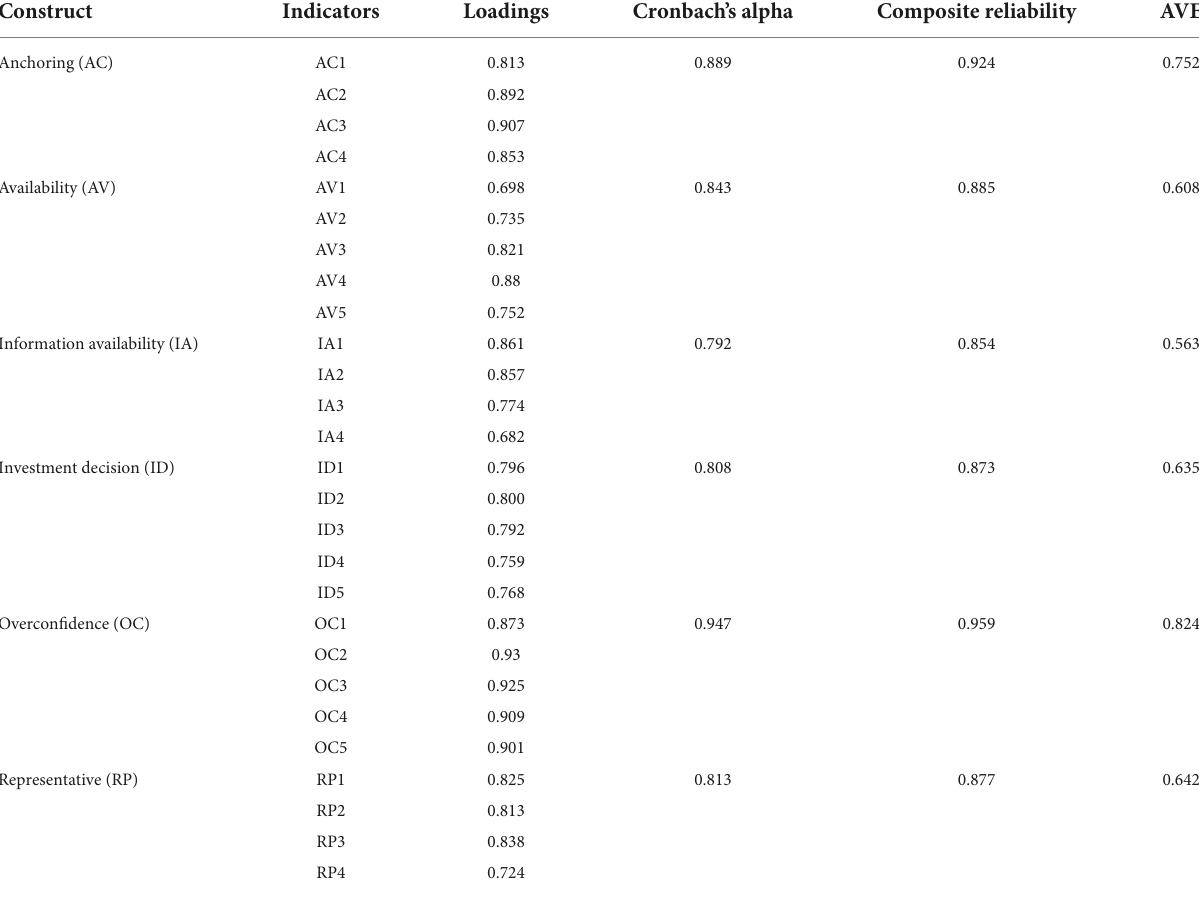
TABLE 1 “Internal consistency, convergent validity, composite reliability, and average variance extracted (AVE)”.